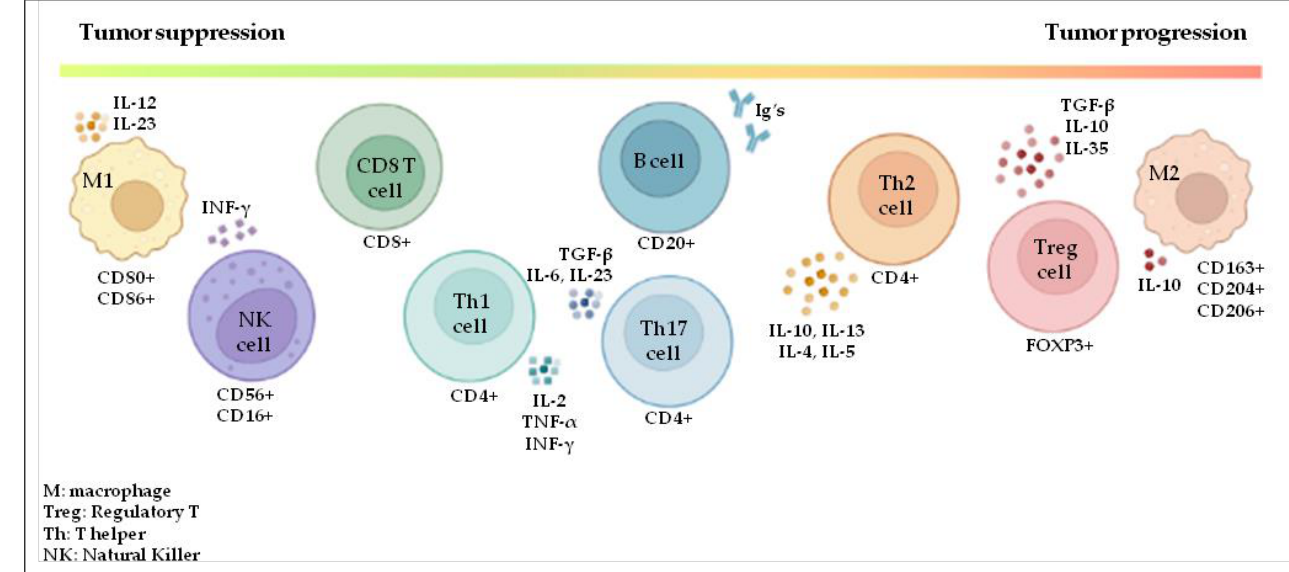
Figure 1. The predominant contribution of the different lymphocytic infiltrates to either tumor sup- pression or progression, including NK cells, cytotoxic T cells, T helper (Th) cell subsets, regulatory T (Treg) cells, B cells, and tumor-associated macrophages, comprising those with antitumorigenic (M1) or protumorigenic (M2) properties. Through the secretion of different factors, these immune populations play key roles in shaping the microenvironment, thereby driving either immune-mediated anti- or protumor activity. (Created with BioRender.com).